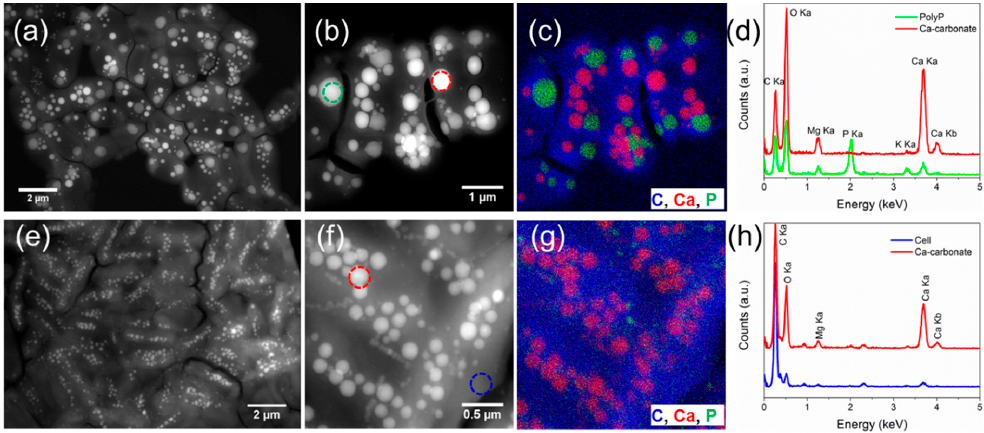
Figure 1. ( a , b ) HAADF-STEM images of Ca . G. lithophora C7 cells grown in BG-11. ( c ) STEM-EDXS map of C7 cells (same area as in ( b )); ( d ) EDX spectra extracted from one single inclusion of Ca-carbonate (red line) and polyphosphate (green line) which are indicated by red and green dashed circles in image b, respectively; ( e , f ) HAADF-STEM images of C7 cells grown in MS-2; ( g ) STEM-EDXS map of C7 cells (same area in ( f )); ( h ) EDX spectra extracted from one single inclusion of Ca-carbonate (red line) and cytoplasm area as background (cell, blue line) which are indicated by red and blue dashed circles on image ( f ), respectively. In ( c , g ), each color in the elemental map corresponds to one element indicated by its own symbol with the same color.